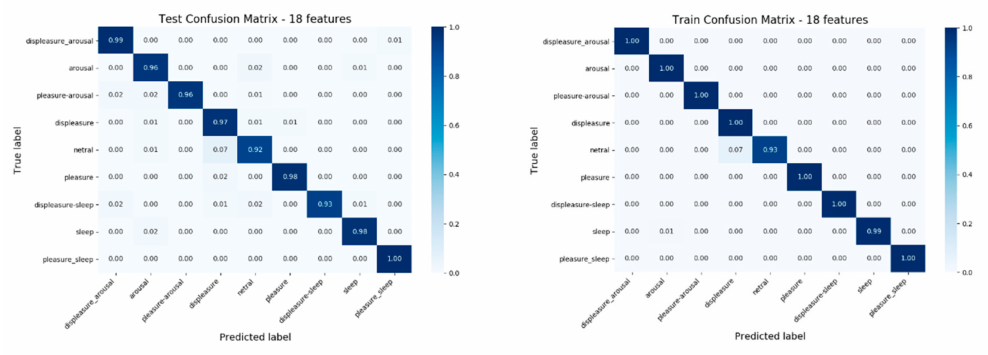
Figure 5. Nine emotions were used as training data and test data for the confusion matrix.